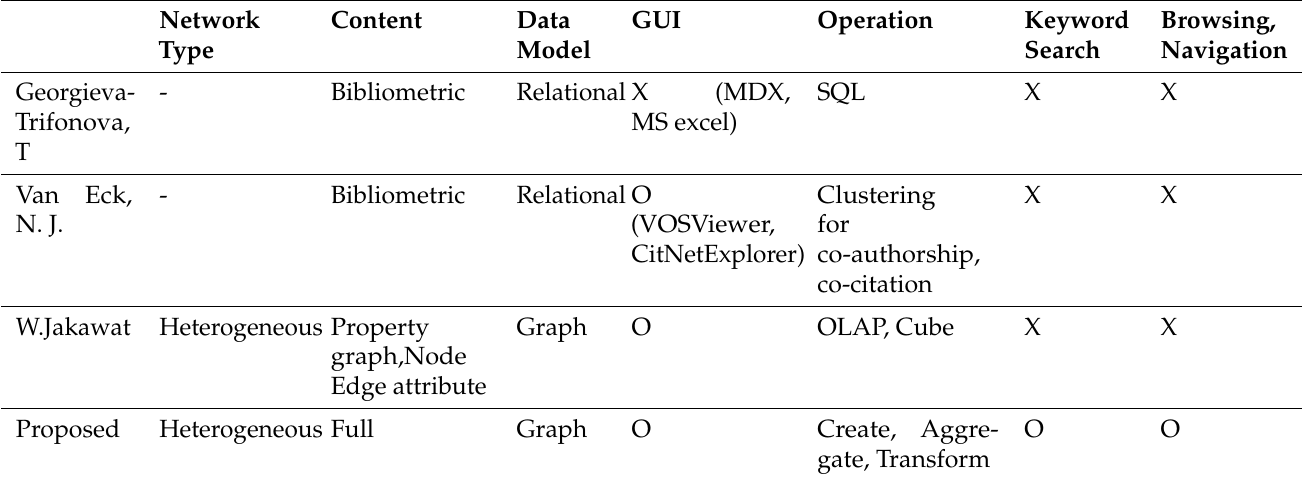
Table 2. Comparison Bibliographic Data Graph Visualization